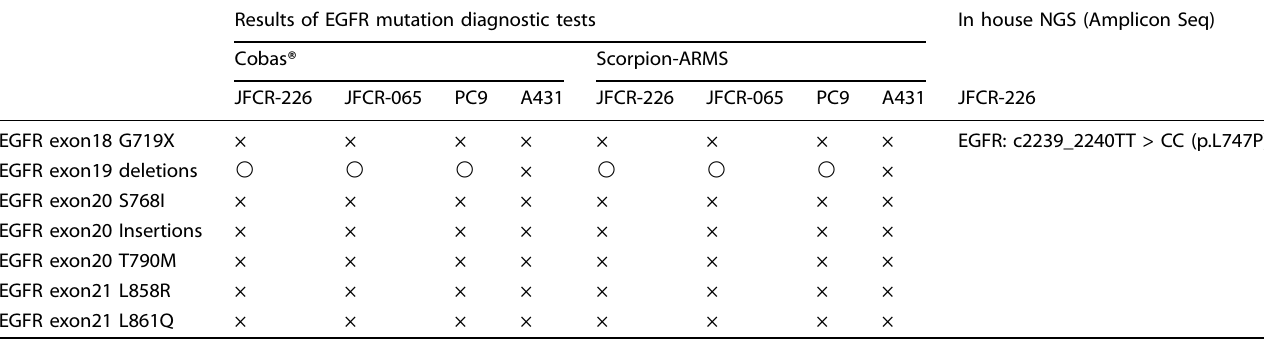
Table 1. Results of the gene mutation